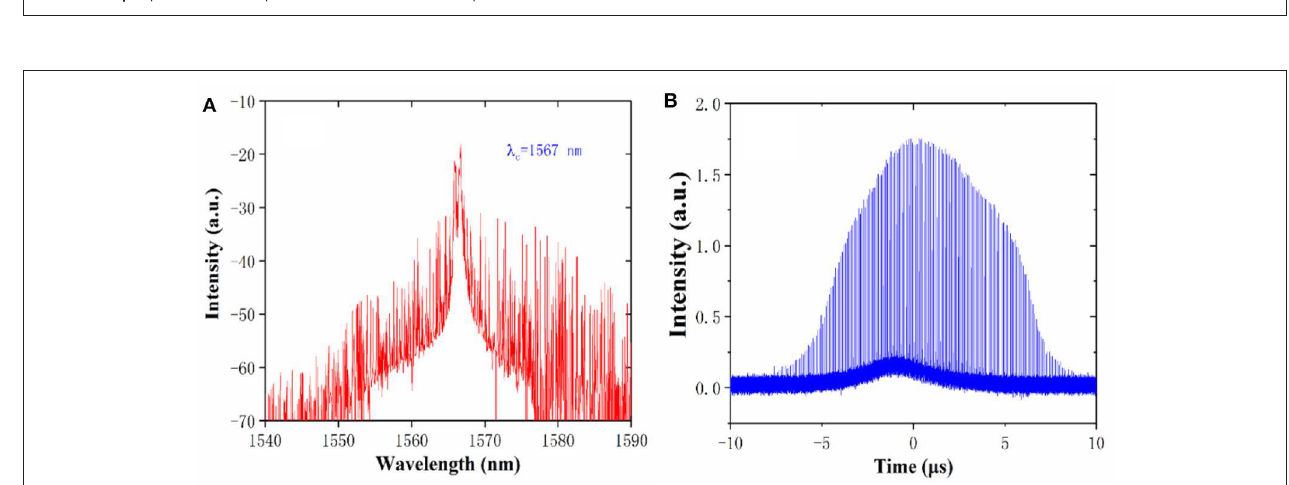
FIGURE 3 | (A) Output spectrum. (B) Q-switched mode-locked pulse